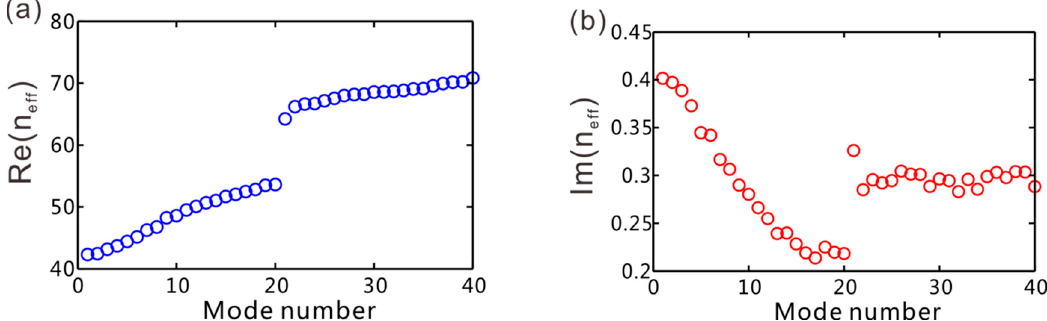
Figure 6. Robustness of the Jackiw-Rebbi against perturbation. The chemical potential (a) real part and (b) imaginary part of effective refractive index.